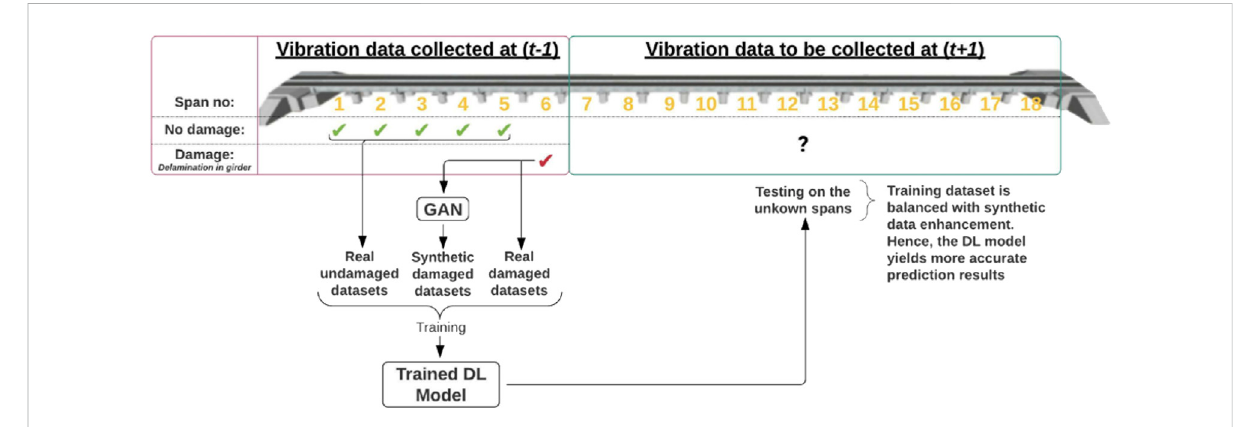
FIGURE 12 GAN augmented vibration-based damage detection via DL model on bridge structures (Luleci et al.,